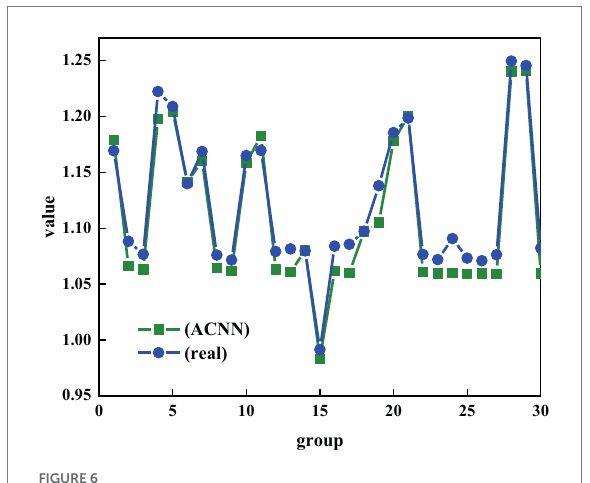
FIGURE 6 Distribution of predicted and actual values of communication medium characteristics of mental health and literature.